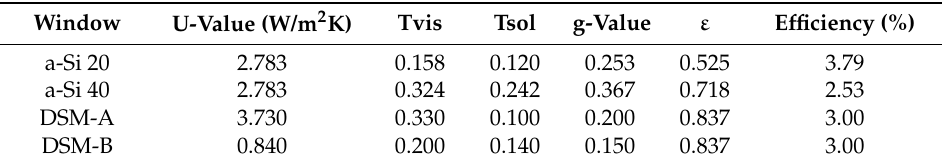
Table 5. Characteristics of STPV elements.